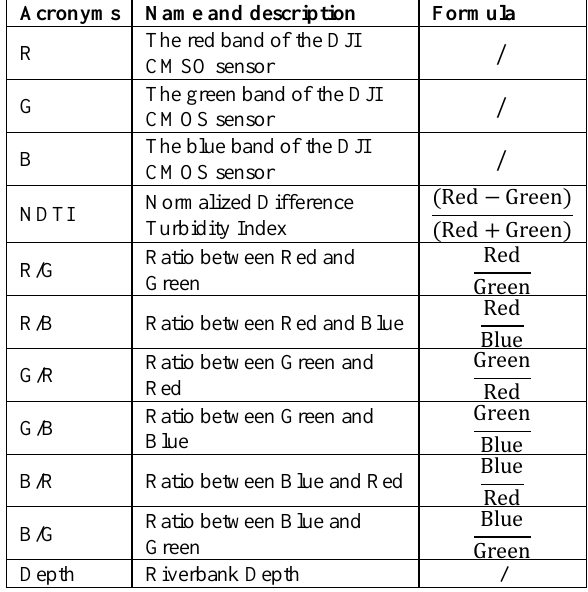
Table 2. Indices and bands compose the input dataset.